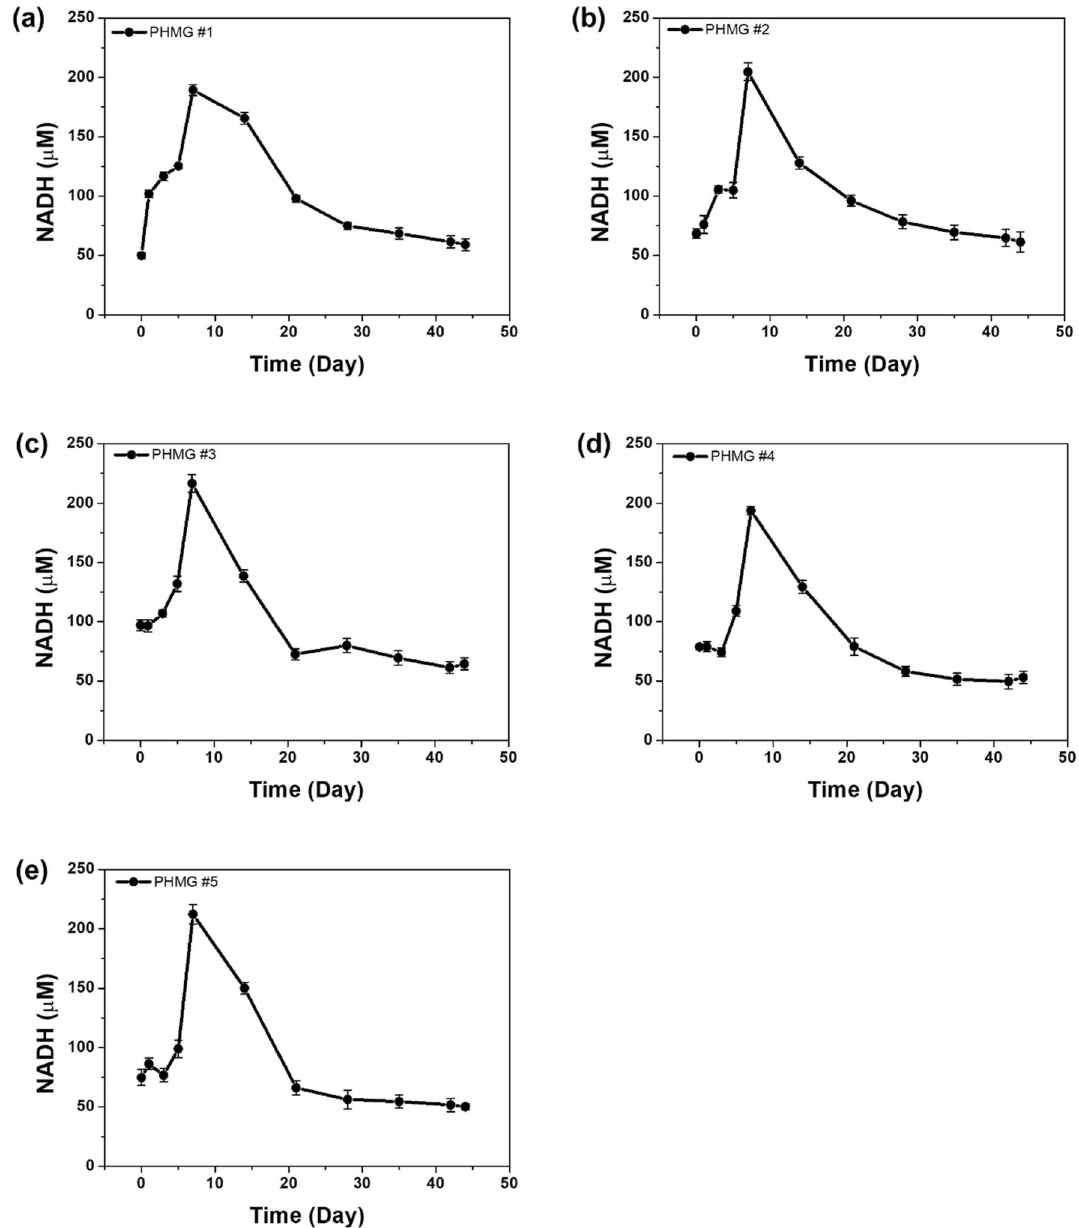
Figure 6. NADH profiles of the PHMG-p exposure groups obtained using an electrocatalytic assay (n = 5).